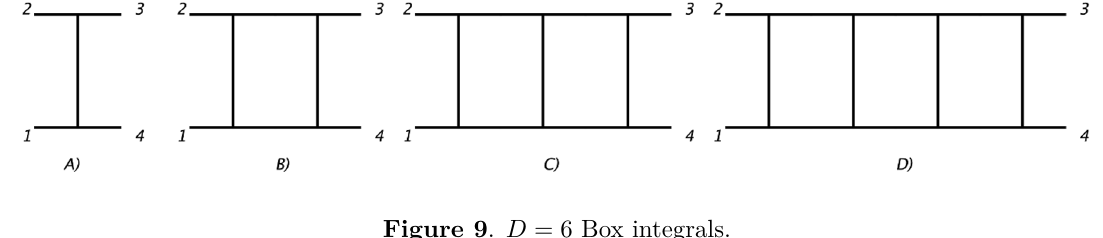
Figure 9 . D = 6 Box